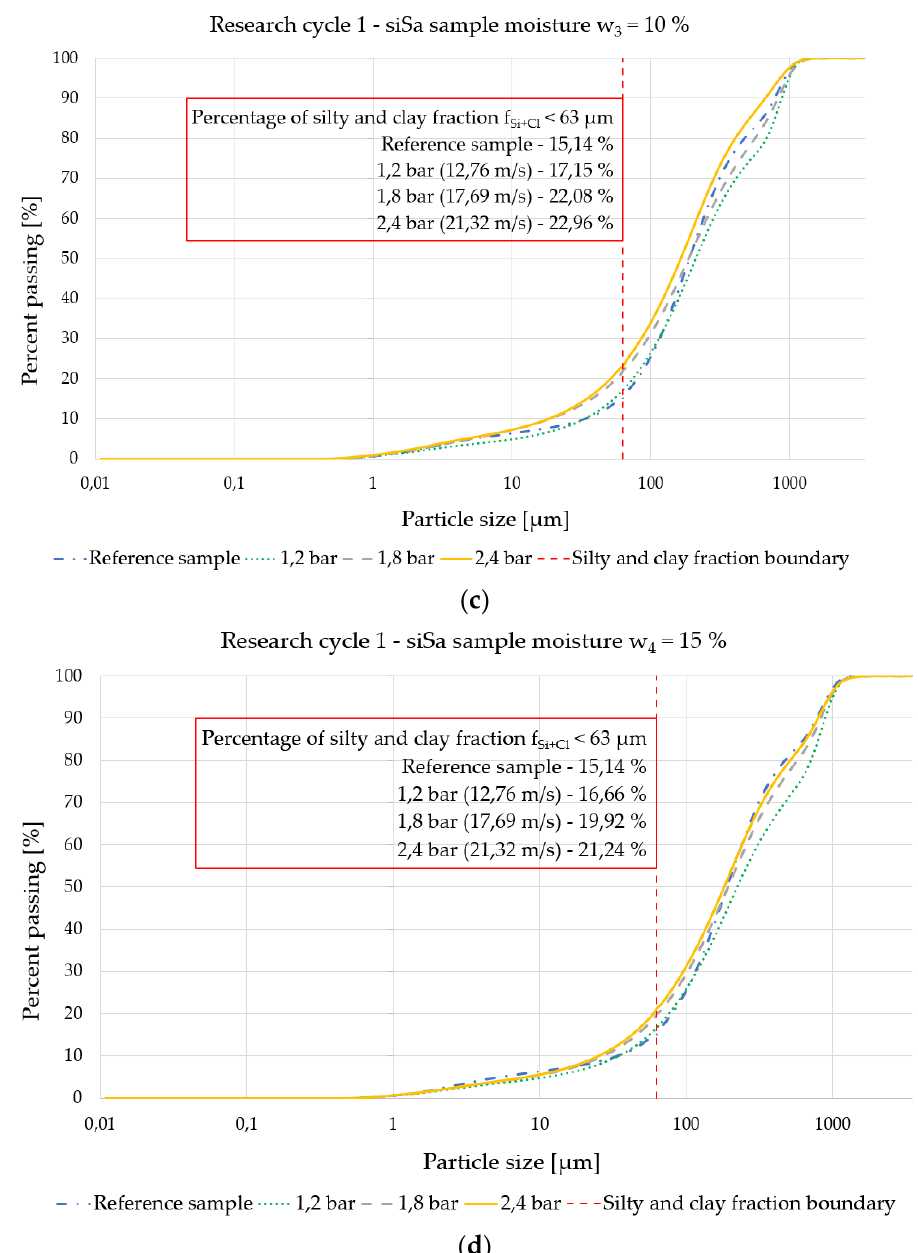
Figure 12. Summary graphs of grain size curves for silty sand with silt and clay fraction f Si+Cl ,1 = 15.14% for sample variants I–XIII (12 sample variants subjected to dynamic impact in SHPB and reference sample without dynamic impact) in variable configurations: ( a ) w 1 and p 1 ( v 1 )– p 2 ( v 2 )– p 3 ( v 3 ), ( b ) w 2 and p 1 ( v 1 )– p 2 ( v 2 )– p 3 ( v 3 ), ( c ) w 3 and p 1 ( v 1 )– p 2 ( v 2 )– p 3 ( v 3 ), ( d ) w 4 and p 1 ( v 1 )– p 2 ( v 2 )– p 3 ( v 3 ). Figure 13a with variable configuration values w 1 = 0% and p 1 = 1.2 bar ( v 1 = 12.76 m/s)– p 2 = 1.8 bar ( v 2 = 17.69 m/s)– p 3 = 2.4 bar ( v 3 = 21.32 m/s); (cid:226) Figure 13b with variable configuration values w 2 = 5% and p 1 = 1.2 bar ( v 1 = 12.76 m/s)– p 2 = 1.8 bar ( v 2 = 17.69 m/s)– p 3 = 2.4 bar ( v 3 = 21.32 m/s); (cid:226) Figure 13c with variable configuration values w 3 = 10% and p 1 = 1.2 bar ( v 1 = 12.76 m/s)– p 2 = 1.8 bar ( v 2 = 17.69 m/s)– p 3 = 2.4 bar ( v 3 = 21.32 m/s); (cid:226) Figure 13d with variable configuration values w 4 = 15% and p 1 = 1.2